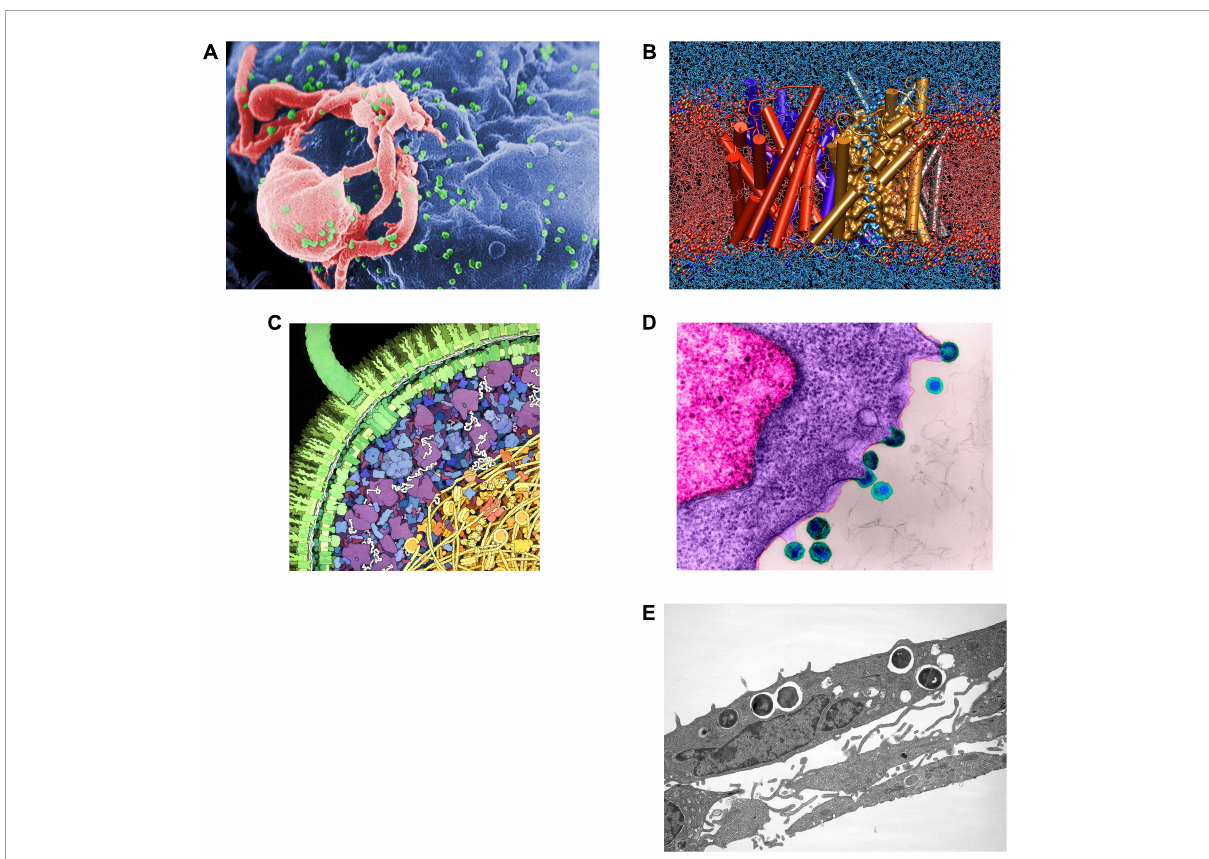
FIGURE2 Example images from each of the five blocks (A–E) of images that were included in discrete choice-inspired comparisons. Block (A) The example image depicts HIV viruses budding from a lymphocyte cell. Credit: Photo Credit: C. Goldsmith, Content Providers: CDC/C.